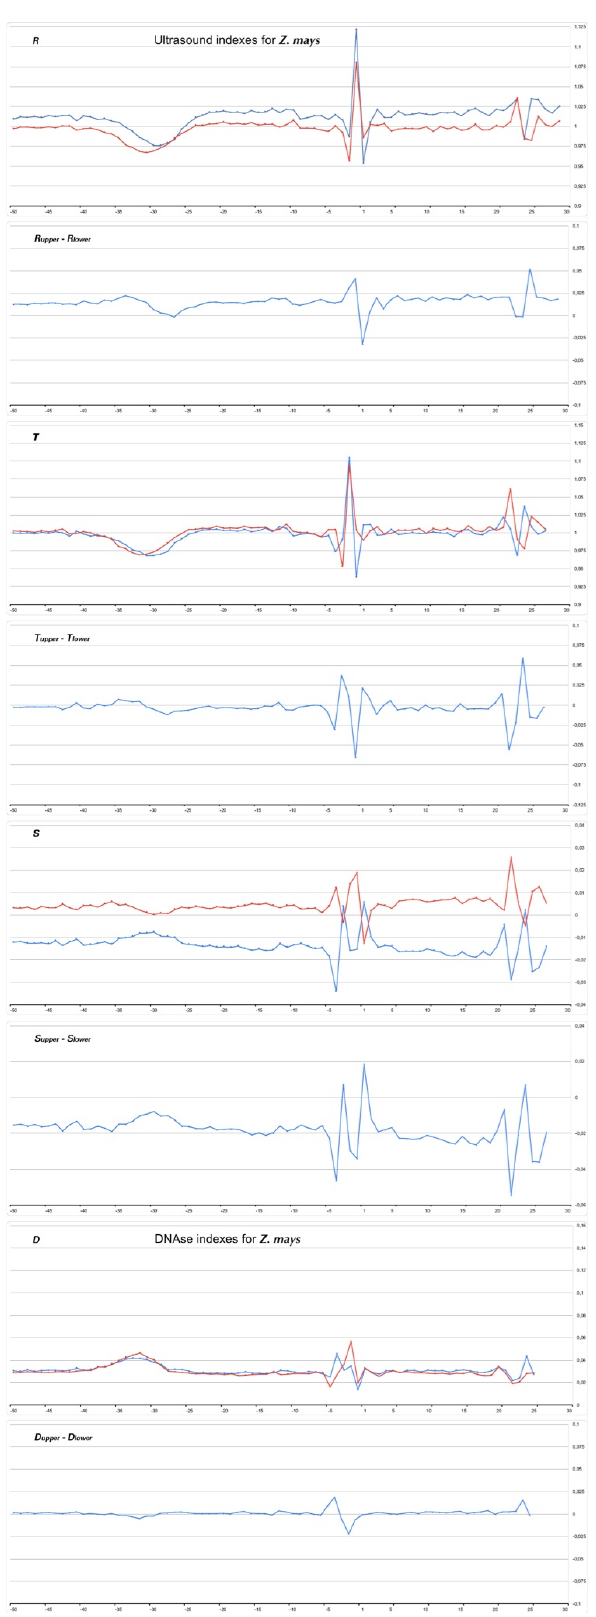
Figure 10. Profiles of ultrasonic cleavage indexes and DNase I cleavage indexes for Z. mays core promoters.